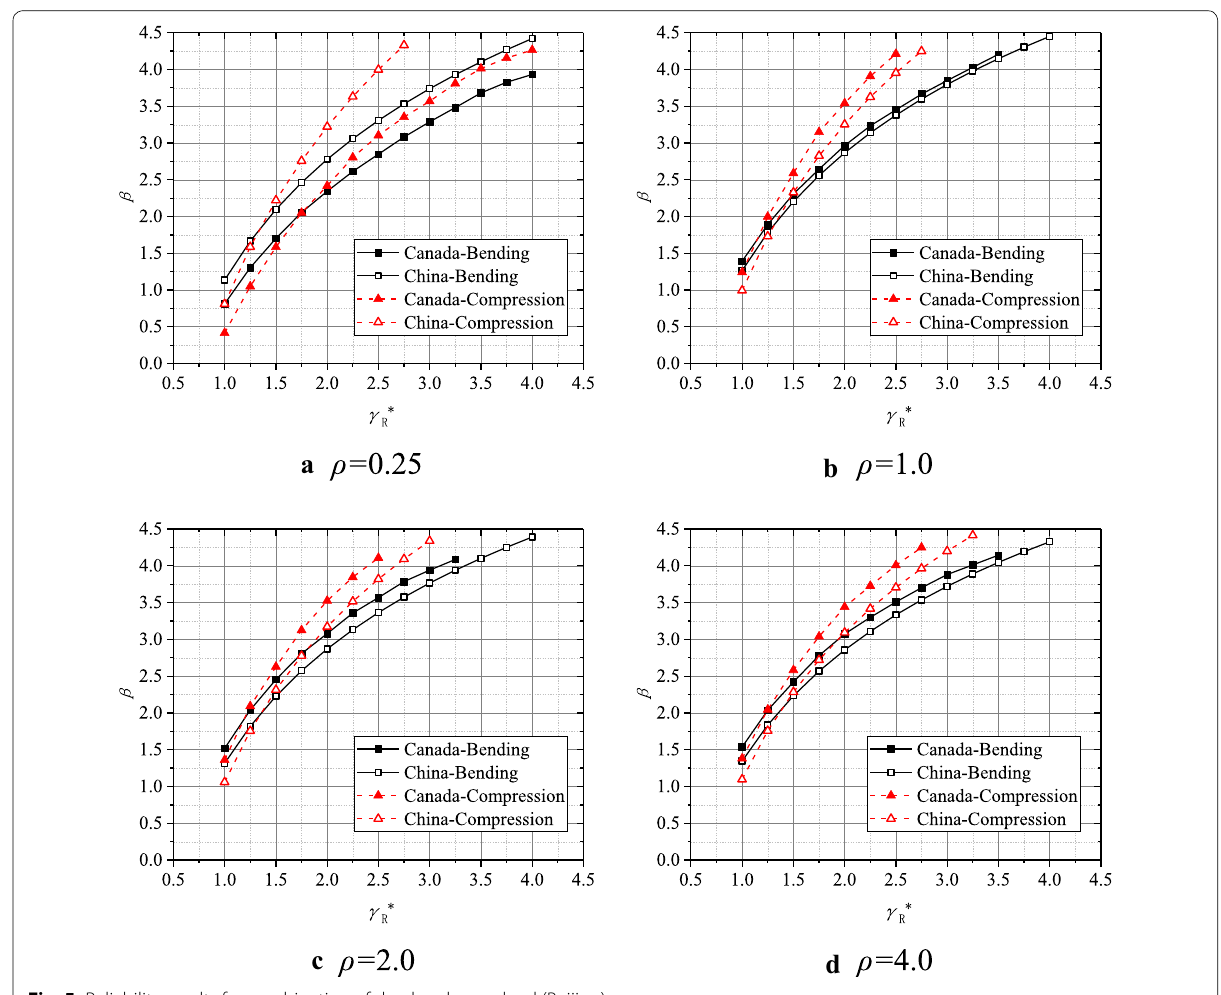
Fig. 5 Reliability results for combination of dead and snow load